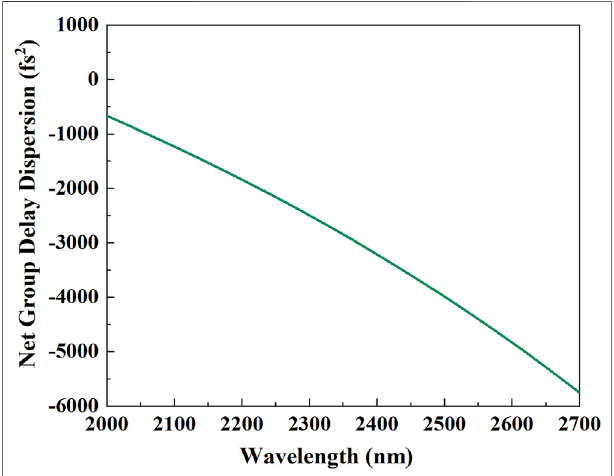
FIGURE 2 | Round-trip net group delay dispersion curve in Kerr-lens mode-locked Cr:ZnS laser.